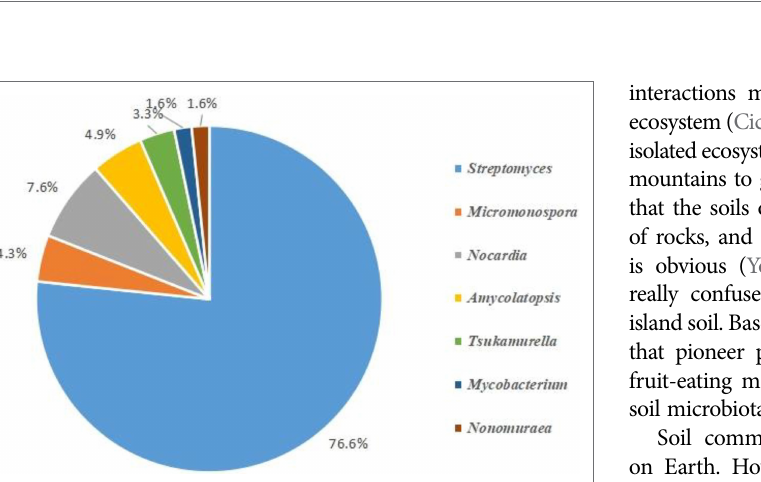
FIGURE 9 | The phylogenetic tree of Actinobacteria OTUs. The branches of the phylogenetic tree labeled with different colors indicate that the genus formed a unique clade and shared <95% of its identity with some known families.